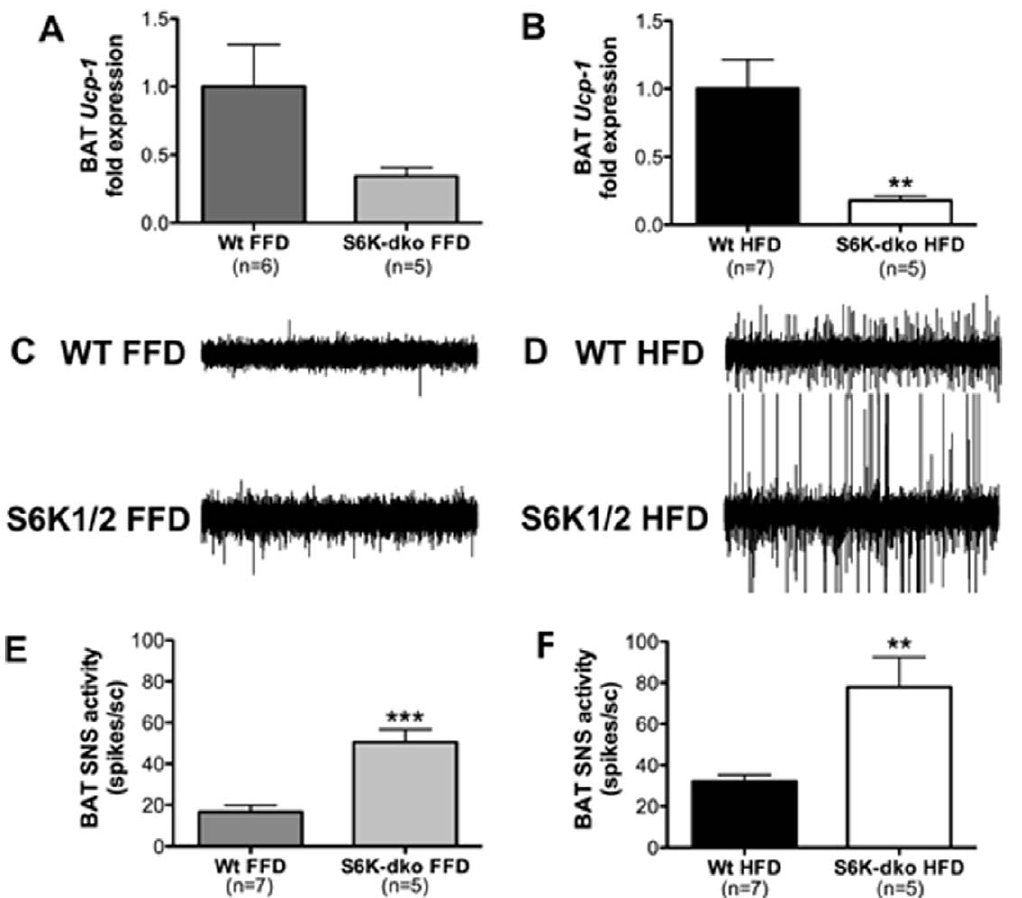
Figure 8. Brown adipose tissue thermogenesis in S6K-dko is diet independent. S6K-dko mice fed a high-fat diet have significantly lower levels of Ucp-1 mRNA in brown adipose tissue (B) and higher sympathetic activity (D, F) compared to wt controls. When fed a fat-free diet, S6K-dko mice show no significant differences in Ucp-1 mRNA levels in brown adipose tissue (A) but do have significantly higher sympathetic activity (C, E) compared to wt controls. BAT, brown adipose tissue; FFD, fat-free diet; HFD, high-fat diet. Two-tailed t test ** P , 0.01, *** P , 0.001.